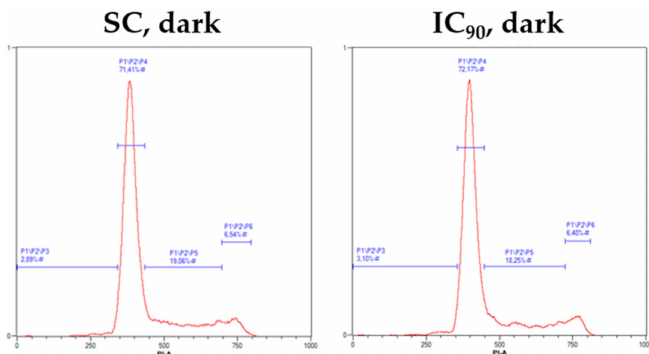
Figure A4. Representative histograms after flow cytometric analysis of cell cycle distribution in SISO cells. Cells were treated with solvent, and the IC 50 or IC 90 of mTHPC. Afterwards, cells were kept in the dark or illuminated with 1.8 J / cm 2 . Fixation and PI staining were carried out 48 h after illumination. For each sample, 10,000 events were counted and gated for the single cell population (not shown) and cells were assigned either sub G 1 (fragmented DNA, apoptotic), G 0 / G 1 , S, or G 2 / M phase. The PI channel ( λ Ex / Em = 488 / 655–730 nm) of a MACS Quant flow cytometer was used for the detection of PI fluorescence. Data were analyzed with the MACS Quantify Software.